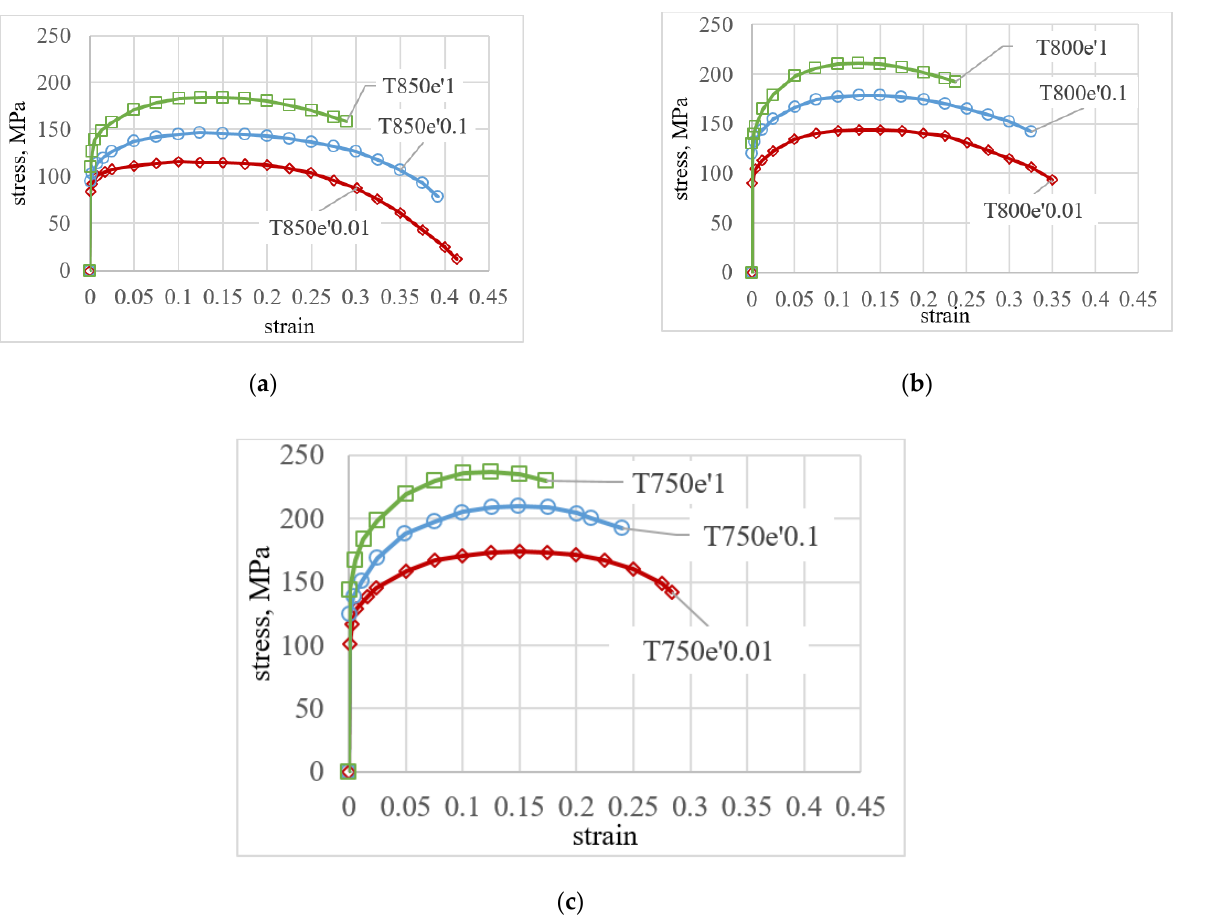
Figure 7. Stress – strain curves of USIBOR ® 2000 under different strain rate (1 s −1 , 0.1 s −1 , 0.01 s −1 ) for Figure 7. Stress–strain curves of USIBOR ® 2000 under different strain rate (1 s − 1 , 0.1 s − 1 , 0.01 s − 1 ) for different test temperatures: ( a ) 850 °C, ( b ) 800 °C, ( c ) 750 ° C . different test temperatures: ( a ) 850 ◦ C, ( b ) 800 ◦ C, ( c ) 750 ◦